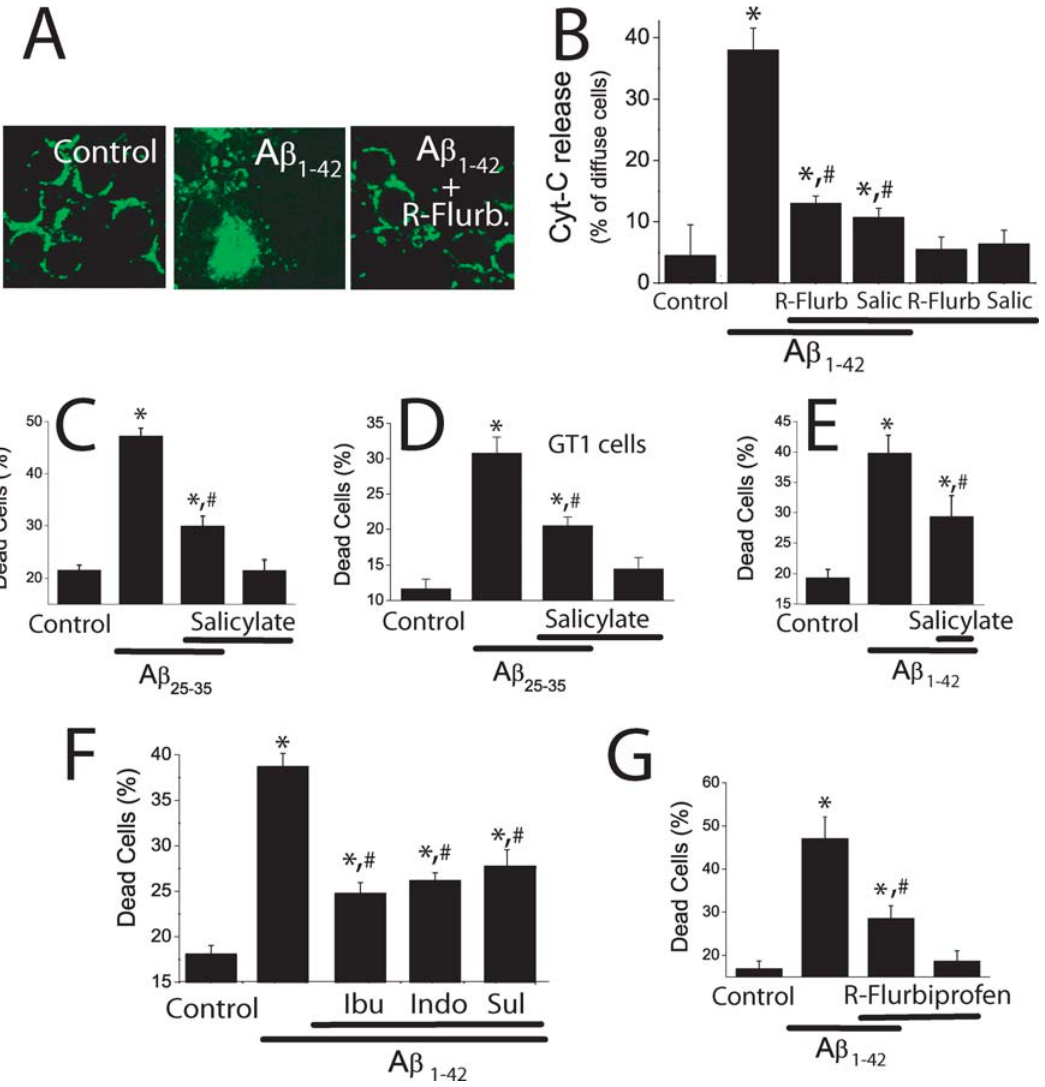
Figure 8. NSAIDs inhibit cytochrome c release and cell death induced by A b 1–42 oligomers. A,B . Cerebellar granule cells were treated with A b 1–42 (500 nM) for 72 h with or without 1 m M R-flurbiprofen or 100 m M salicylate and fixed for analysis of cytochrome c location using confocal microscopy. A . Control cells showed a punctate distribution of cytochrome c. Scale bar represents 10 m m. A b 1–42 oligomers-treated cells show a more diffuse pattern of cytochrome c whereas cells treated with A b 1–42 oligomers plus R-flurbiprofen show a punctate pattern similar to control cells. B . Bars show the relative abundance (%) of cells showing diffuse immunostaining in control cells, cells treated with A b 1–42 oligomers and cells treated with A b 1–42 oligomers plus 1 m M R-flurbiprofen or 100 m M salicylate (B). *p , 0 05 vs control; # p , 0 05 vs A b ; data from at least 3 independent experiments. Salicylate 100 m M inhibits cell death induced by A b 25–35 (20 m M) in cerebellar granule cells (C) and GT1 cells (D). Salicylate 100 m M also inhibits cell death induced by A b 1–42 oligomers (500 nM) in cerebellar granule cells (E). (*p , 0 05 vs control; # p , 0 05 vs A b . n=3). F. Ibuprofen (Ibu), Indomethacin (Indo), and sulindac sulfide (Sul), all tested at 1 m M, inhibit cell death induced by A b 1–42 oligomers (500 nM) in cerebellar granule cells. G. R-Flurbiprofen 1 m M also inhibits cell death induced by A b 1–42 oligomers (500 nM). *p , 0 05 vs . control; # p , 0 05 vs A b . All data are representative of 3